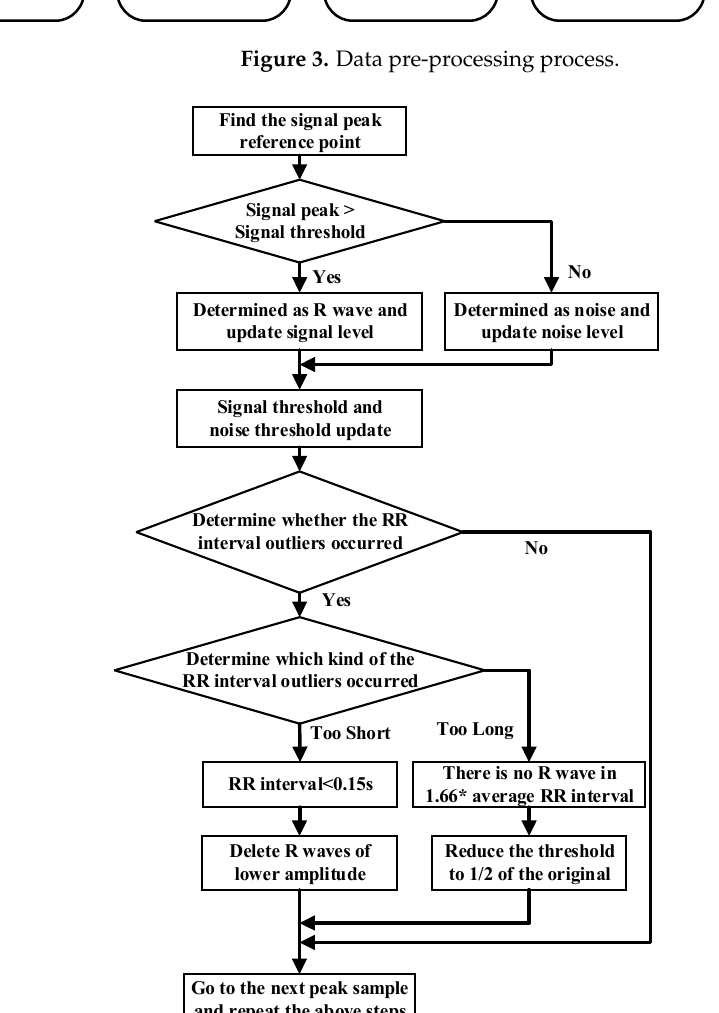
Figure 4. Flow chart of R threshold detection with the dynamic threshold algorithm.